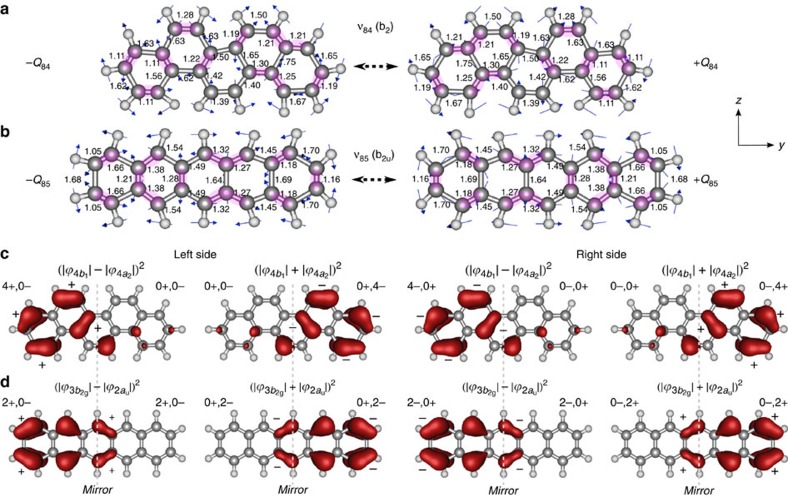
Vibronic C=C stretch antisymmetric modes and π-electron–mode coupling phases.Displaced cationic structures linked by non-totally symmetric C=C stretch modes (a) ν84 (picene+) and (b) ν85 (pentacene+). The vibrational motion of these modes consists of in-plane C=C stretches with a perfect antisymmetric reflection relative to the molecular xz plane (perpendicular to this page). The electronic density amplification in contracted bonds is coloured purple. Bond length values shown in Å. (c,d) Vibronic coupling phases between excited π-electron density redistributions and maximum displaced nuclear positions for picene+ and pentacene+ reveal the positive π-density build-up on left or right sides relative to the molecular xz plane. The smaller-size signs depicted for the two-carbon density centers over the centrosymmetric inner ring in pentacene+ illustrate a weak vibronic coupling as based on the relatively smaller C=C bond-length changes and reduced π-electron density (see text). Molecular structures and spin-orbital wavefunctions from B3LYP/6-311G** calculations.